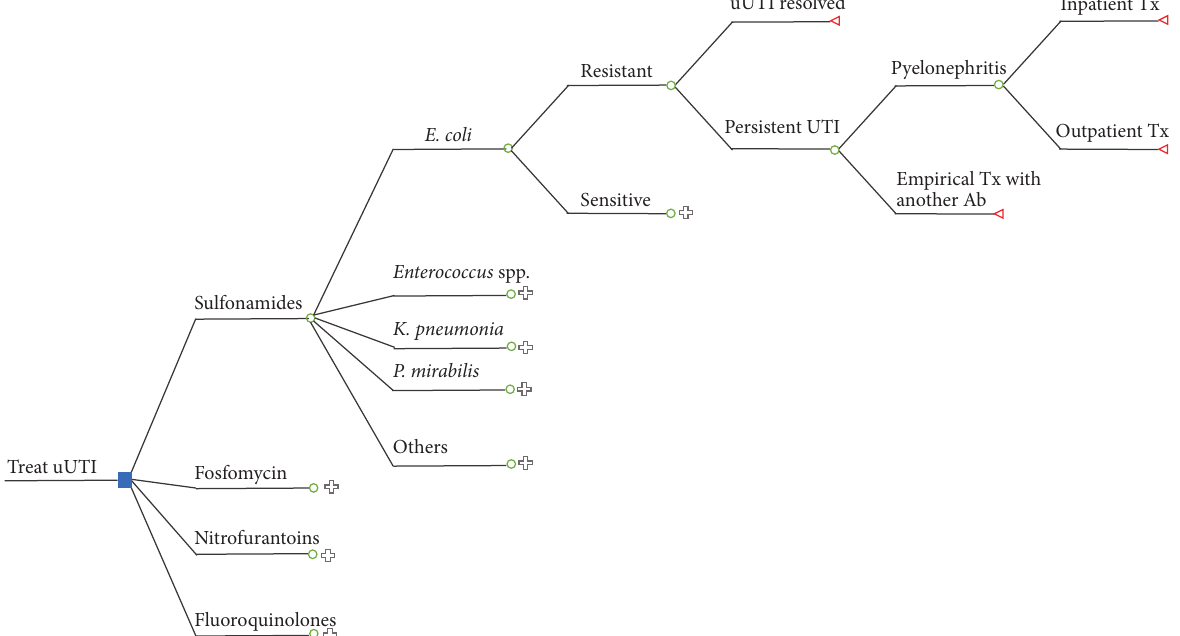
Figure 1: Decision-tree diagram showing intermediate and final outcomes for an uncomplicated E. coli UTI treated with a sulfonamide. Table 1: Cost of antibiotics and healthcare resources used for the treatment of uUTIs and the ranges tested in the sensitivity analyses. Variable Base case (CAD $) Range tested (CAD $)